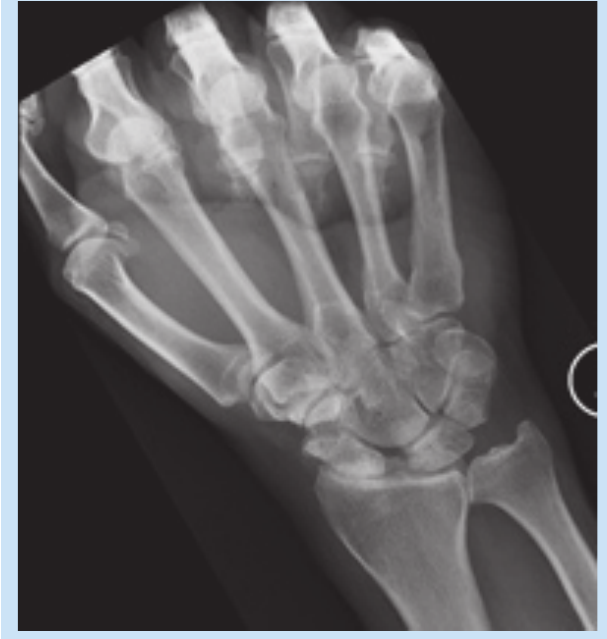
Fig. 2. The gap is more pronounced in the clenched hand-position.